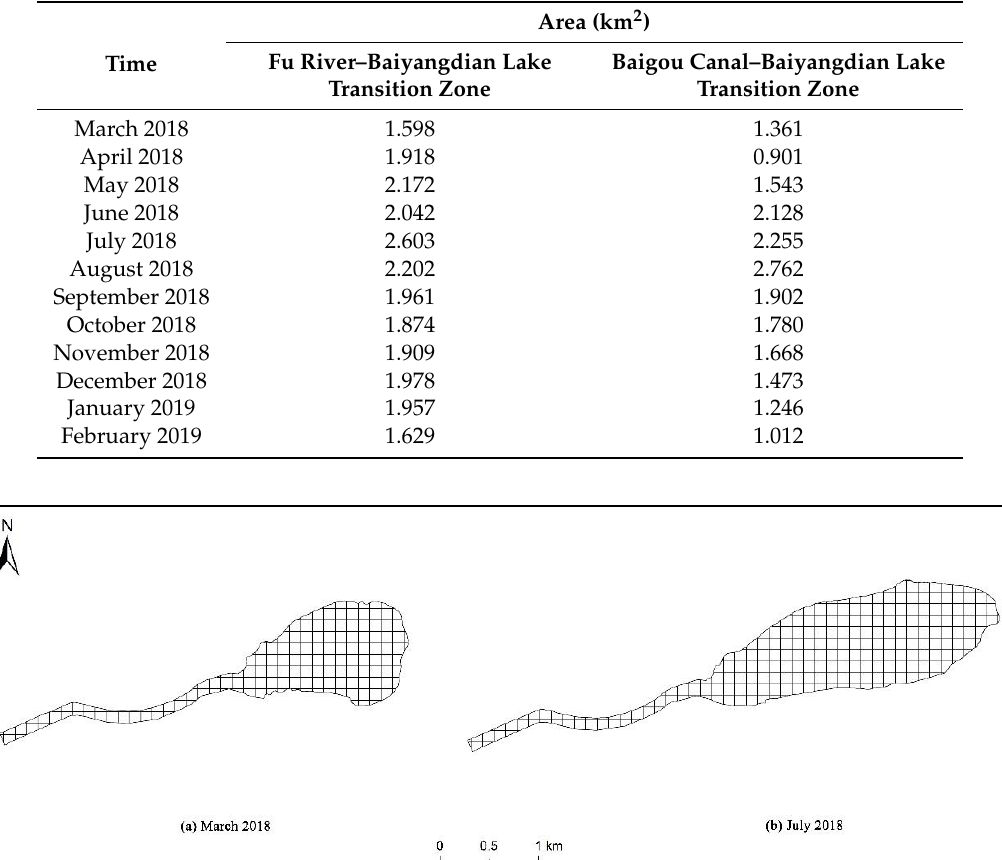
Table 4. Areas of the river–lake transition zones.